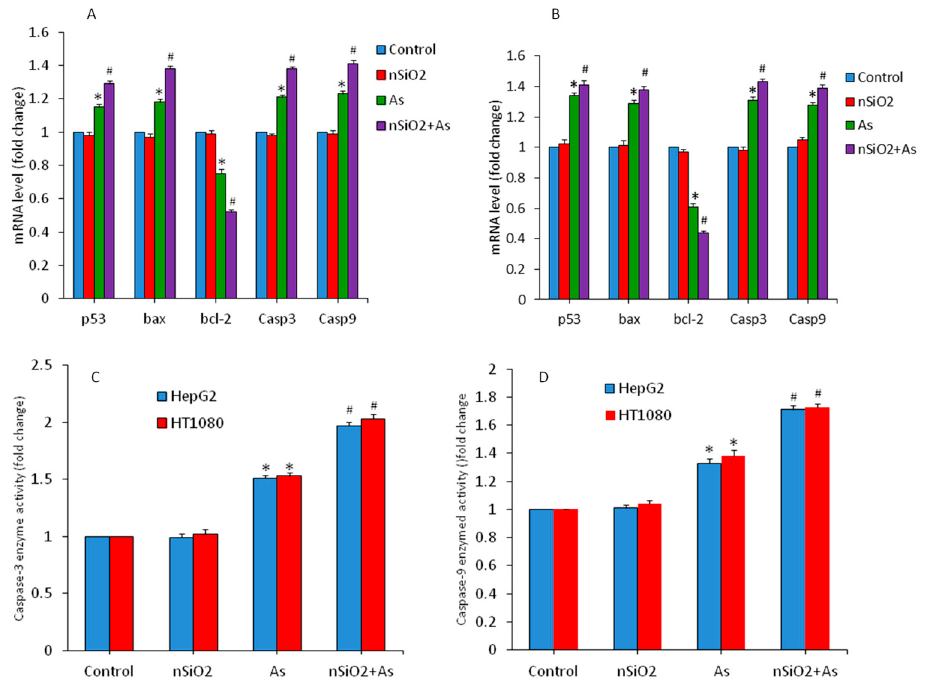
Figure 5. Expression of apoptotic genes and enzymes in HepG2 and HT1080 cells exposed for 24 h to nSiO 2 (10 μ g/mL), As (1 μ g/mL) or SiO 2 + As (10 μ g/mL + 1 μ g/mL). ( A ) mRNA level of apoptotic